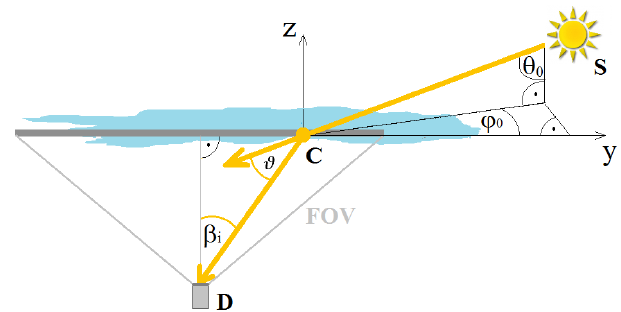
Fig. 3. Illustration of the AisaEAGLE measurement geometry in a Cartesian coordinate system ( x,y,z ) with position of the Sun (S), a scattering cloud particle (C) and the AisaEAGLE detector (D). θ 0 is the solar zenith angle, ϕ 0 the solar azimuth angle, ϑ the scattering angle, and β i the viewing angle of the corresponding